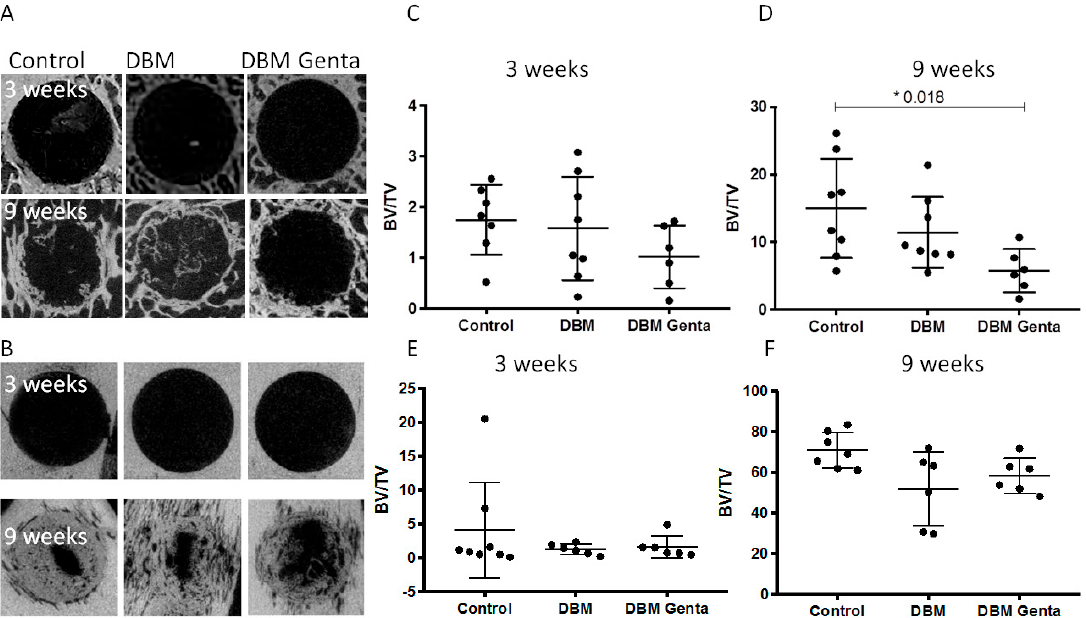
Figure 2. μ CT images of representative metaphyseal and diaphyseal bone defects after three and nine weeks of healing ( A , B ). The metaphyseal defects ( A ) showed healing only at the nine weeks. ( C – F ) Quantification of the BV/TV in the defects at three and nine weeks